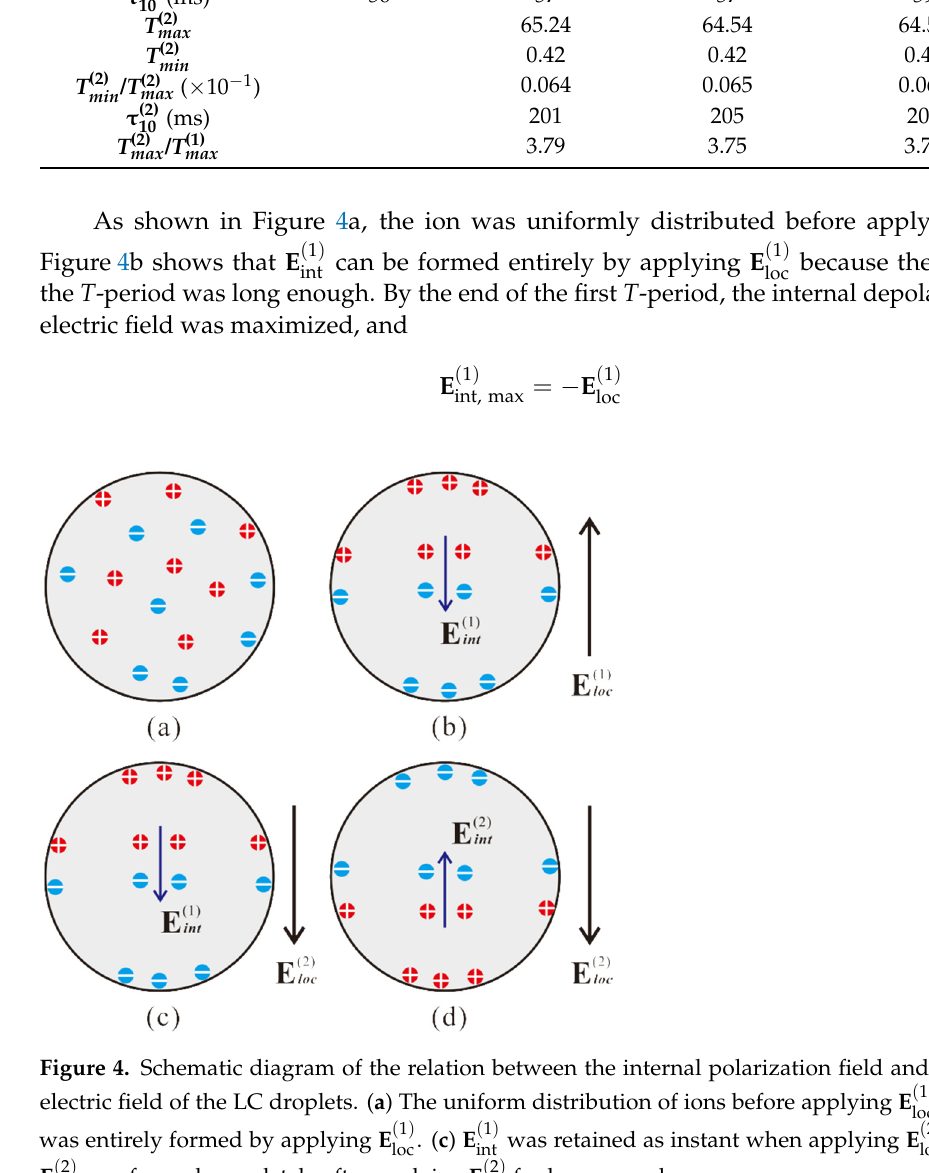
loc(1) int(1) ( 1 ) ( 1 ) . ( c ) 𝐄 was retained as instant when applying 𝐄 . ( c ) E was retained as instant when applying E int loc ( 2 ) for long loc